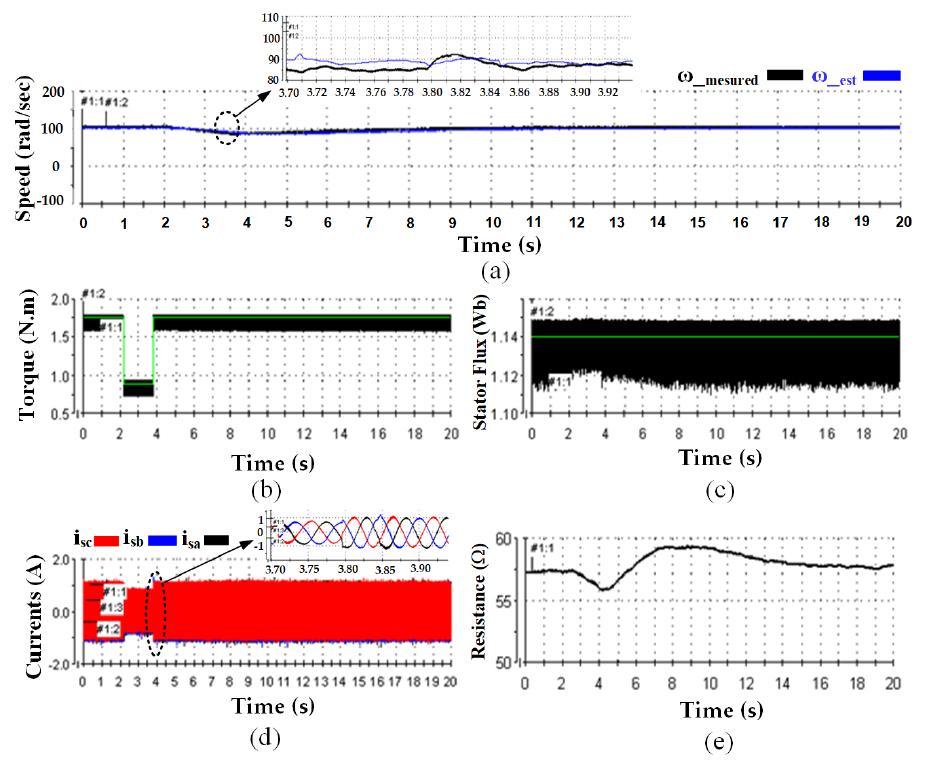
Figure 34. The DTC strategy with the adaptive estimator: ( a ) Speed response, ( b ) Torque response, ( c ) Stator flux, ( d ) Stator currents, ( e ) Stator